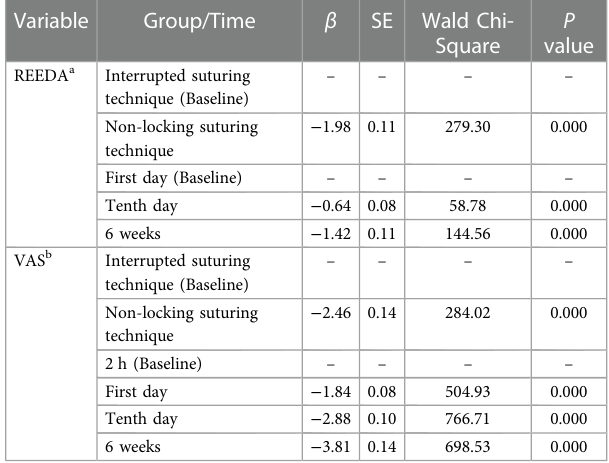
TABLE 3 Results of generalized estimating equations model in examining the trend of changes in variables of redness, oedema, ecchymosis, discharge, approximation scale and visual analogue scale in terms of groups and time.